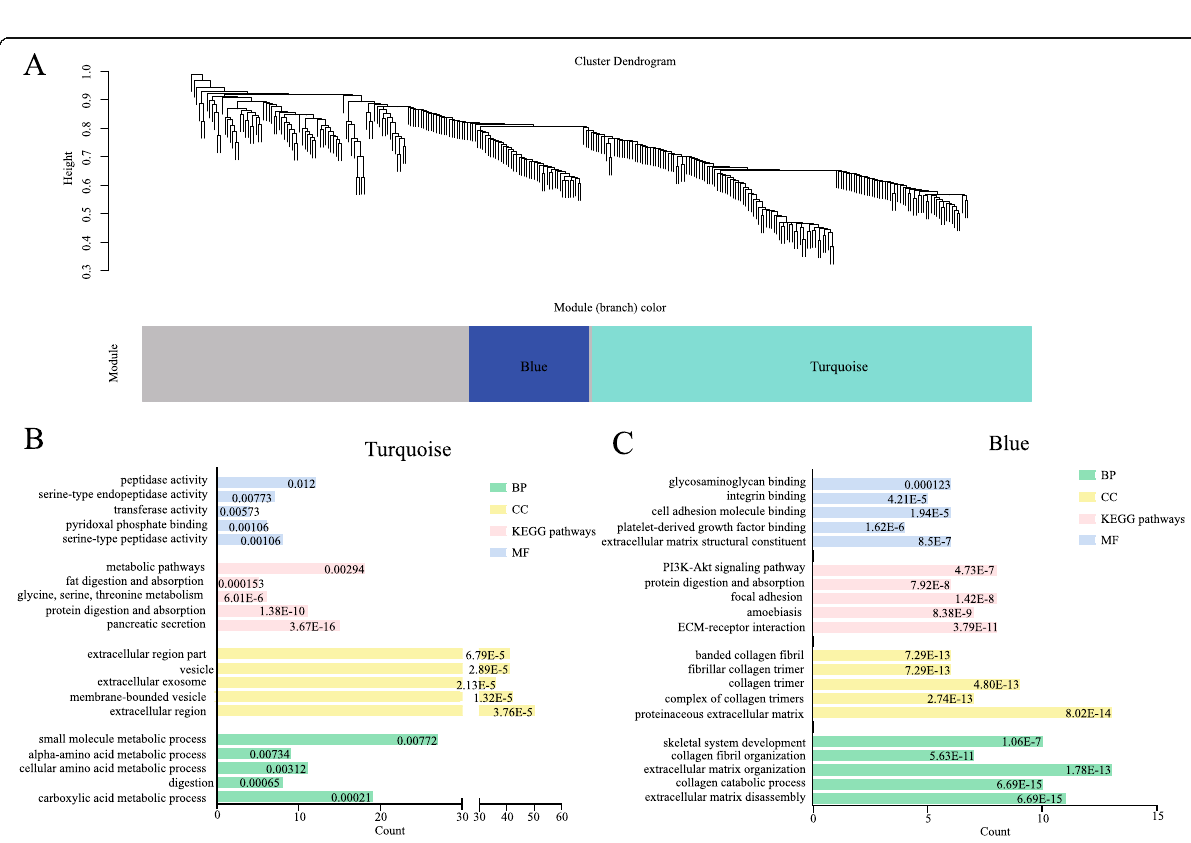
Fig. 3 WGCNA analysis of the differentially expressed genes and Gene ontology enrichment analysis and KEGG pathway analysis of the functioned modules ( a ) Gene clustering and module identification was made by WGCNA analysis on the basis of the gene chip-GSE28735. Cluster dendrogram diaplayed the result of hierarchical clustering, and each line represented a gene. The colored column below the dendrogram represented module conducted by the static tree cutting method. The blue and turquoise color show different co-expression network modules for DEGs and grey module represents insignificant module. b - c Gene ontology enrichment analysis and KEGG pathway enrichment analysis of turquoise ( b ) and blue ( c ) module. The vertical axis represented GO term or pathway, and the horizontal axis represented count of genes. The value of false discovery rate was shown at the end of each column. BP, biological process; CC, cellular component; MF, molecular function; KEGG, Kyoto encyclopedia of genes and genomes; WGCNA, weighted gene co-expression network